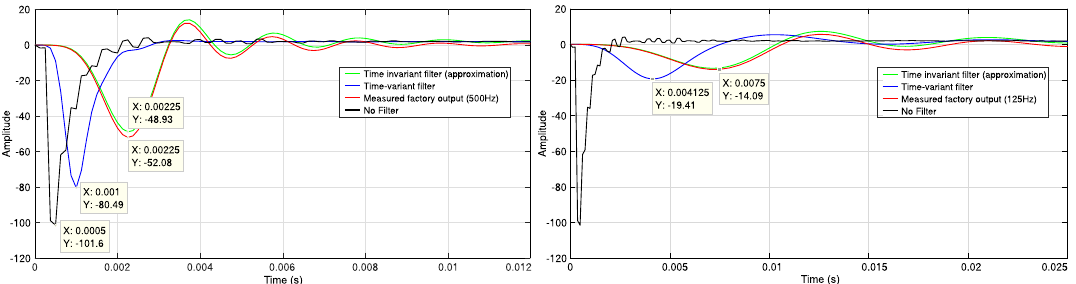
Figure 11. Impulse responses of filtering systems comparison for 500 Hz and 125